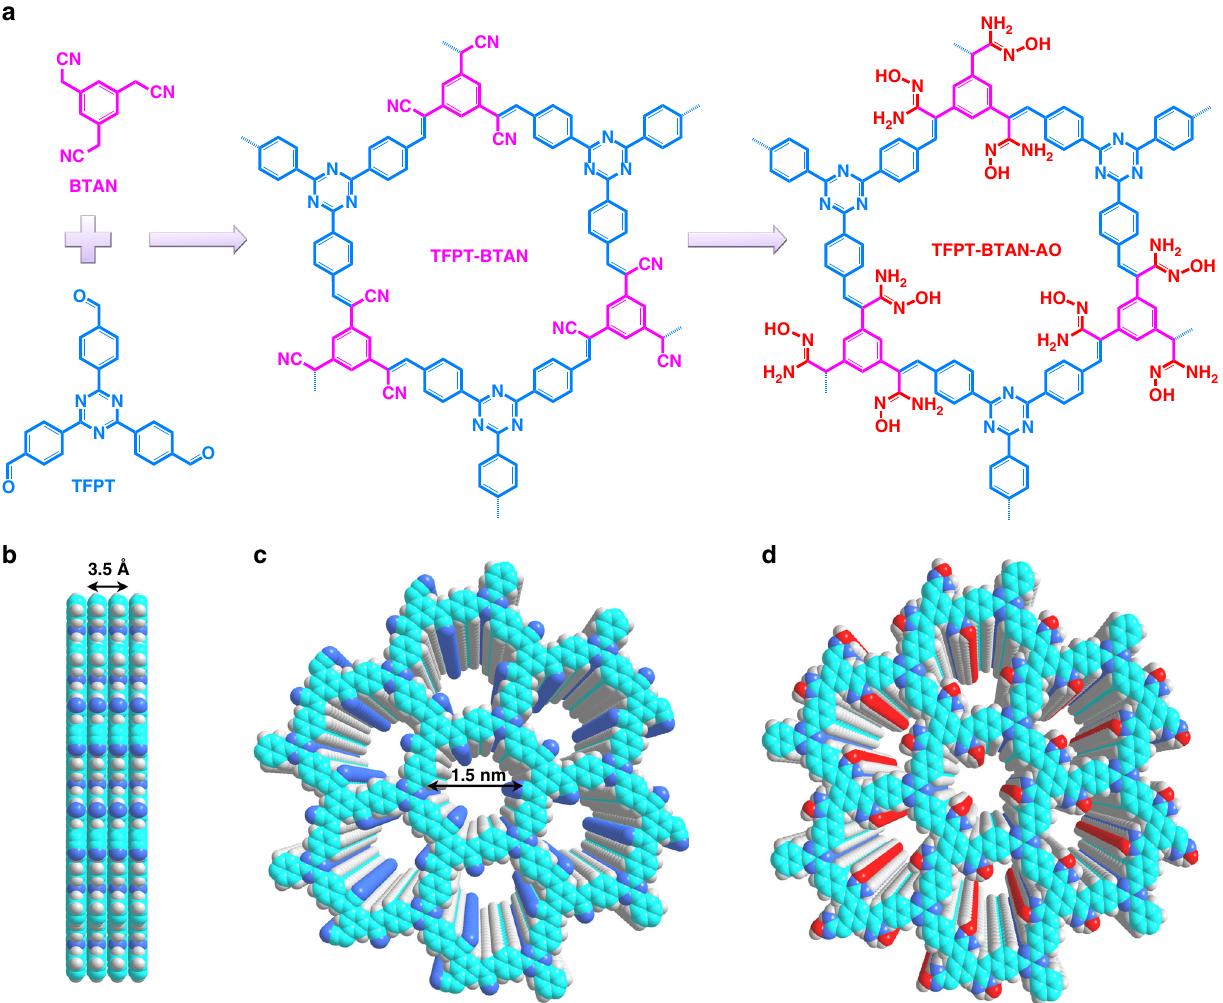
Fig. 1 Schematic of synthetic TFPT-BTAN-AO. a Synthesis of TFPT-BTAN and TFPT-BTAN-AO. b Side and top c views of an eclipsed AA-stacking model of TFPT-BTAN (light green, C; blue, N; light gray, H). d Graphic view of TFPT-BTAN-AO (light green, C; red, O; blue, N; light gray,